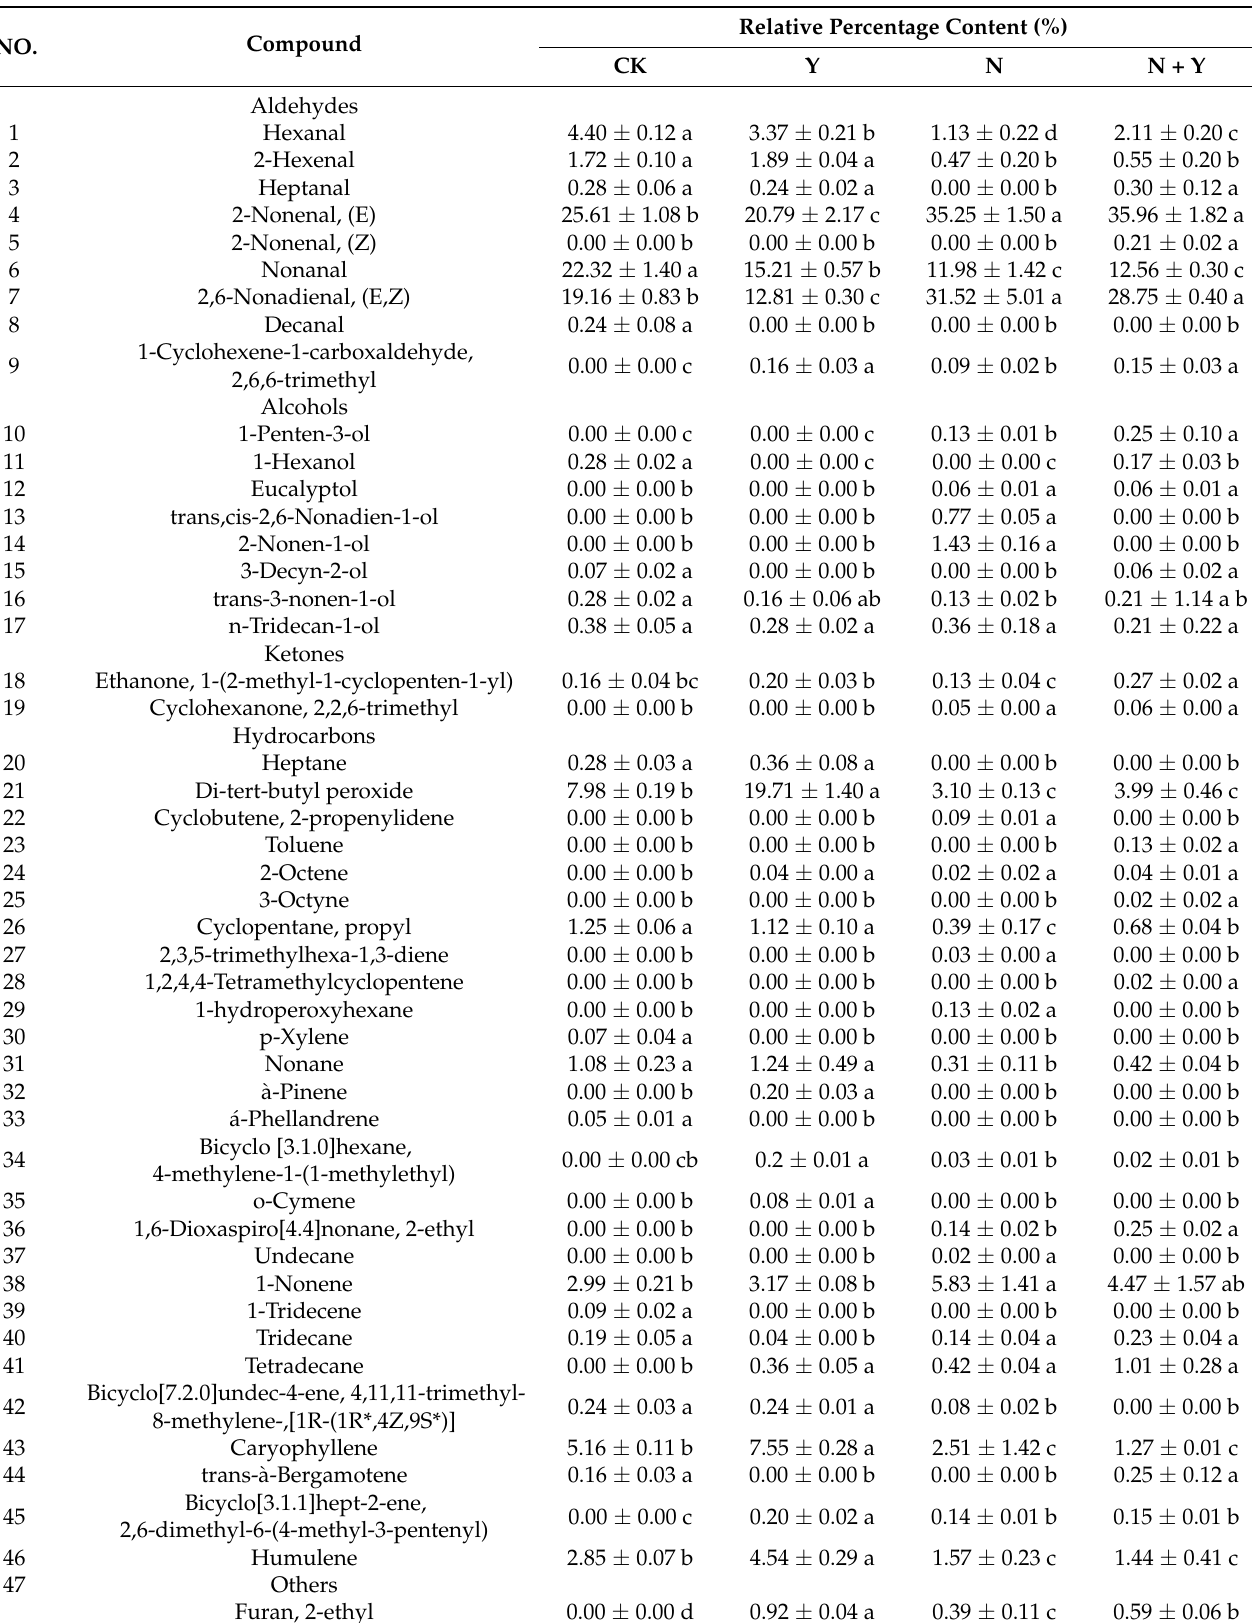
Table 3. The relative contents and aroma compounds of fresh cucumbers in different